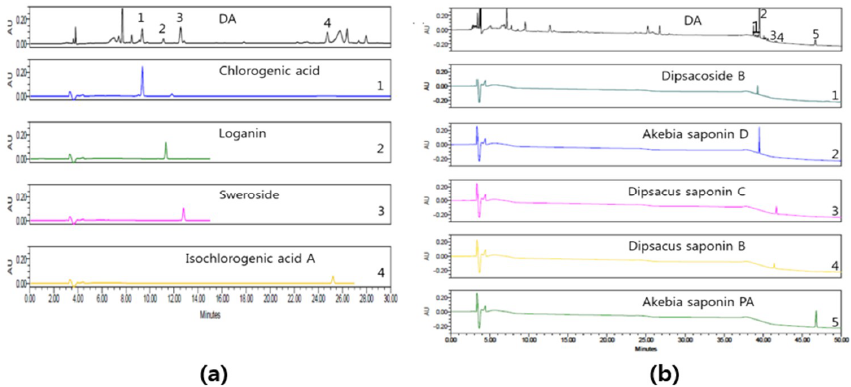
Figure 1. Chromatogram of Dipsacus asperoides C. Y. Cheng et T. M. Ai (DA) detected at 237 ( a ) and 198 nm ( b ).